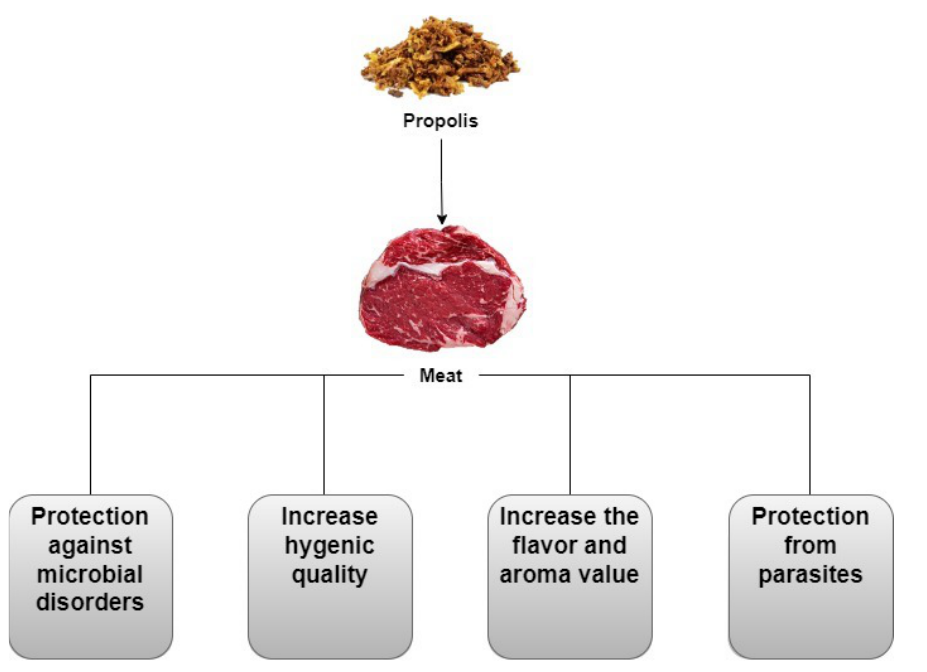
Figure 2. Effect of propolis on meat .